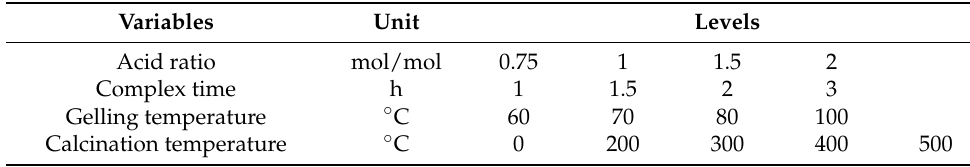
Table 4. Variables of sol-gel method and their